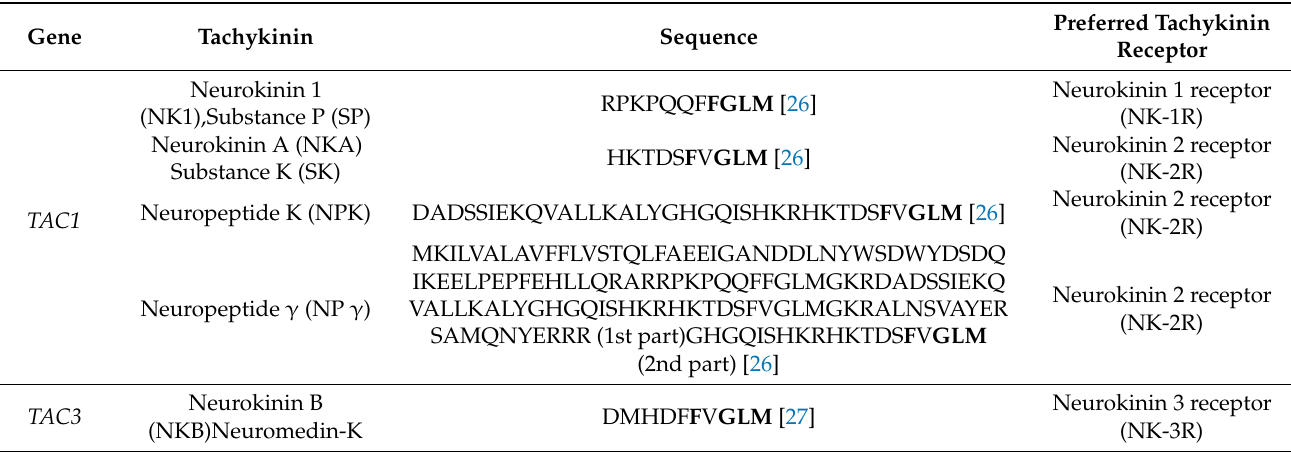
Table 1. Main members of the human tachykinin